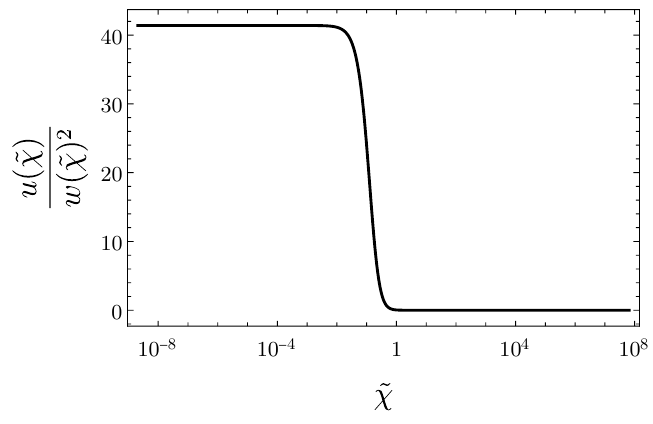
Figure 6 . Critical trajectory of u/w 2 as function of ˜ χ , for N S = 1 , N V = N F = 0 .